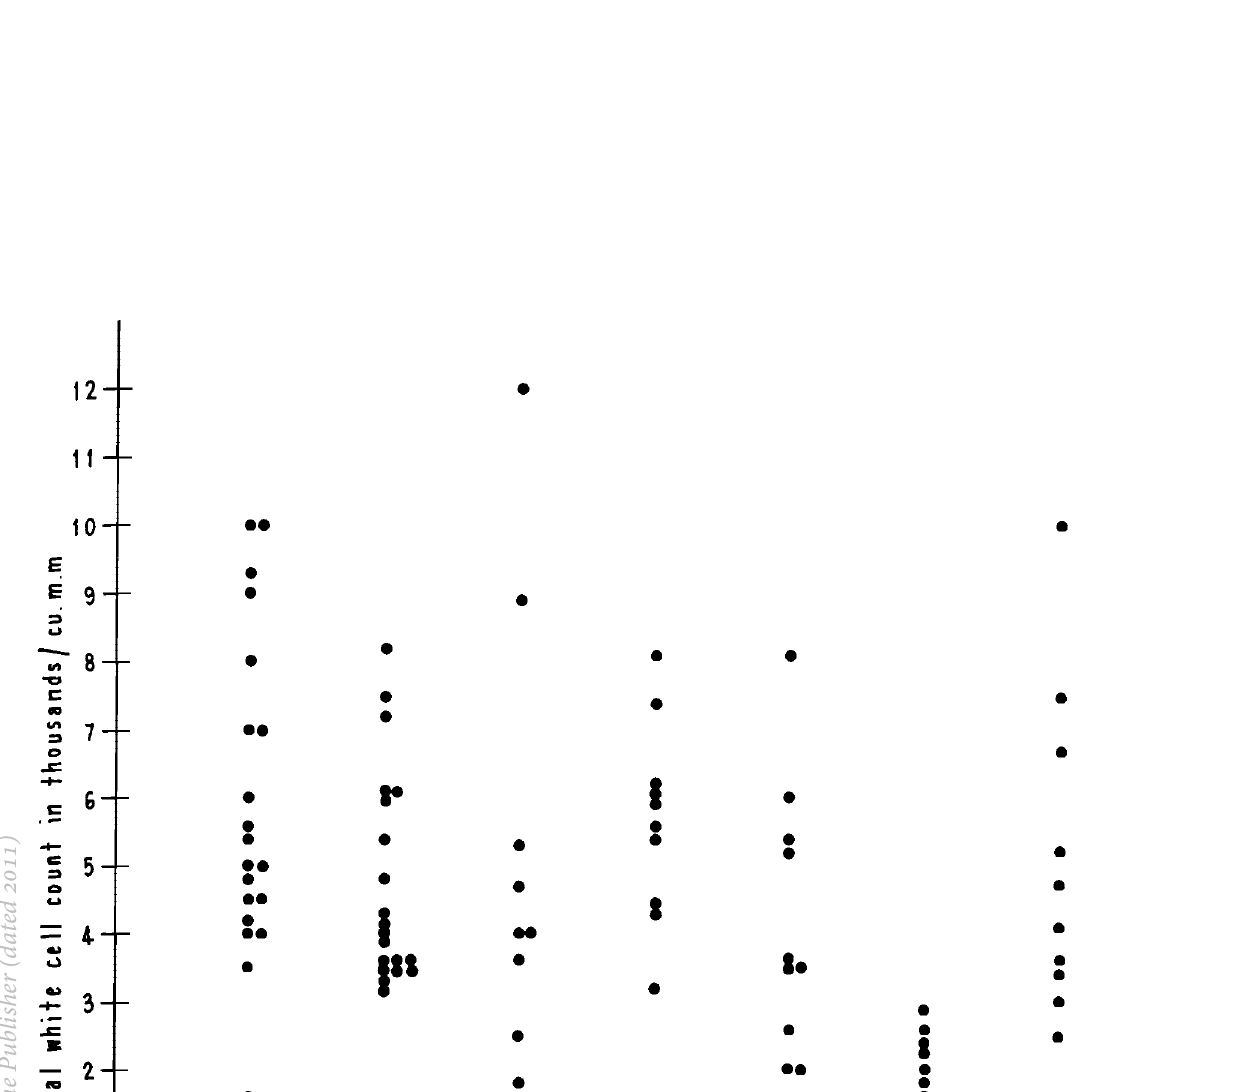
fig·5 Values obtained for total white cell tount. • indicahs one value for one